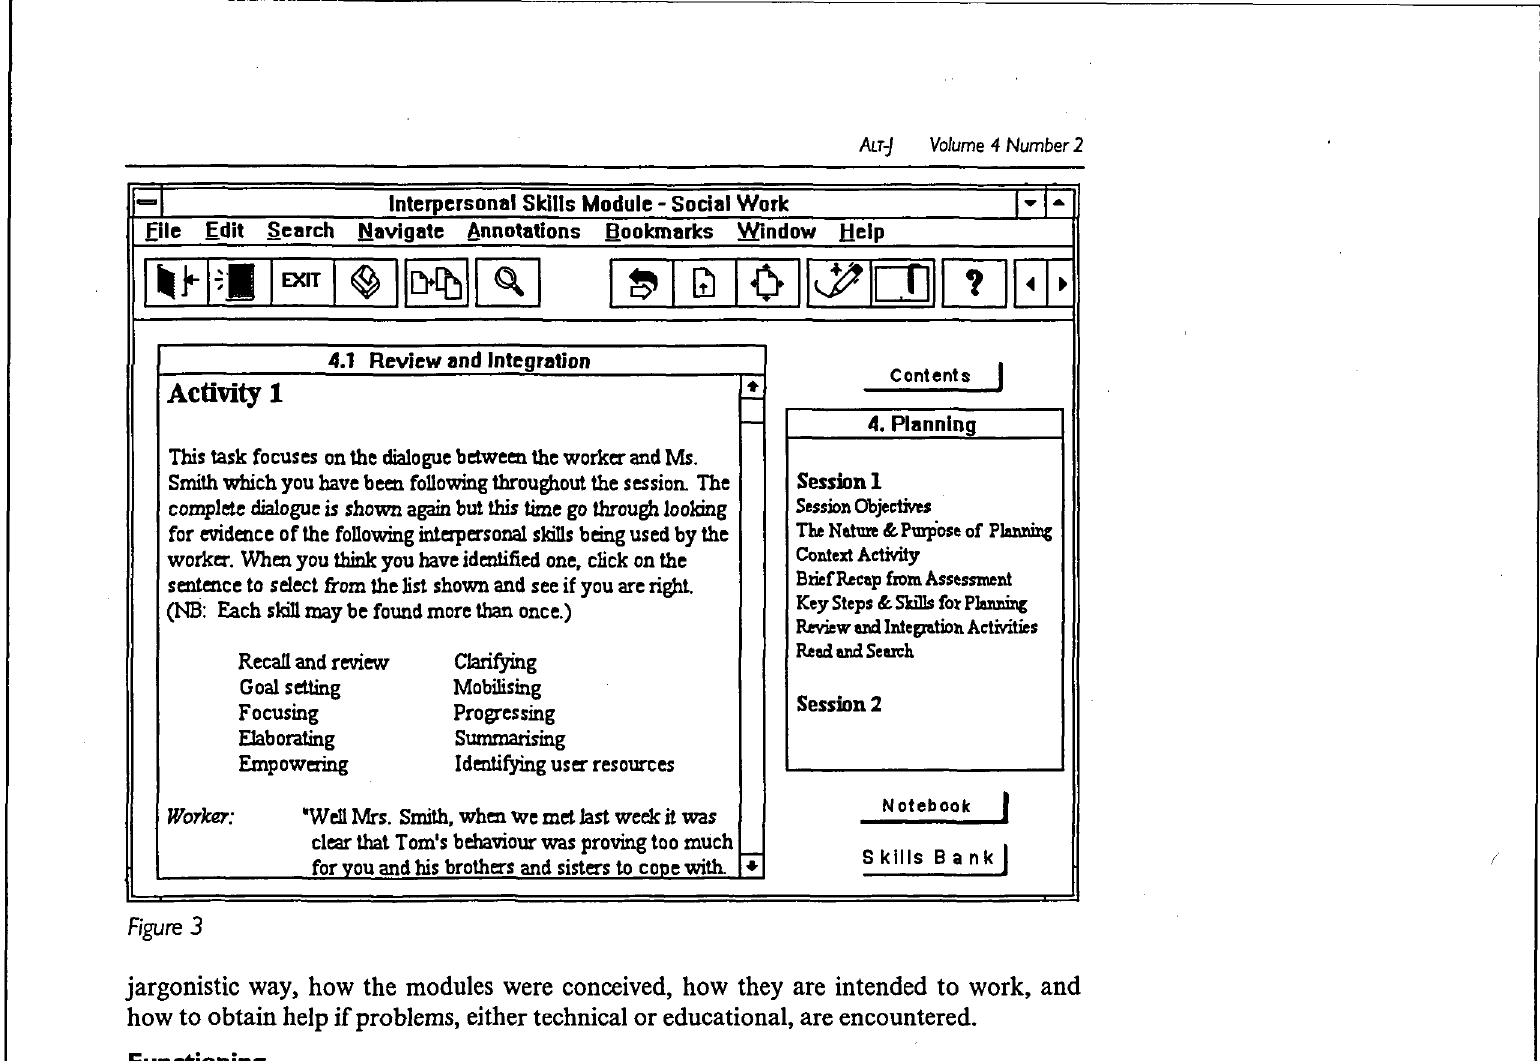
jargonistic way, how the modules were conceived, how they are intended to work, and how to obtain help if problems, either technical or educational, are